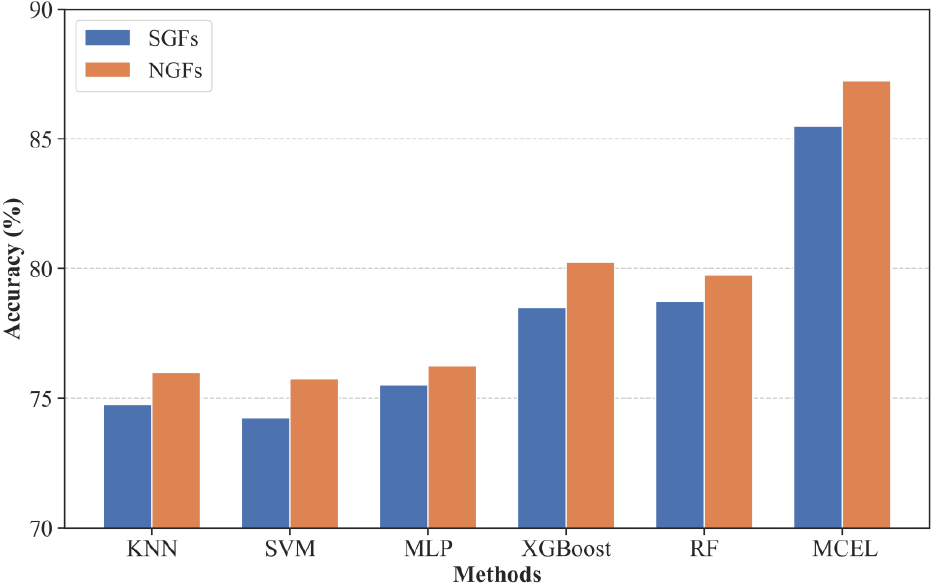
Table 2. Ship classification accuracy of different methods on the AIS test set.